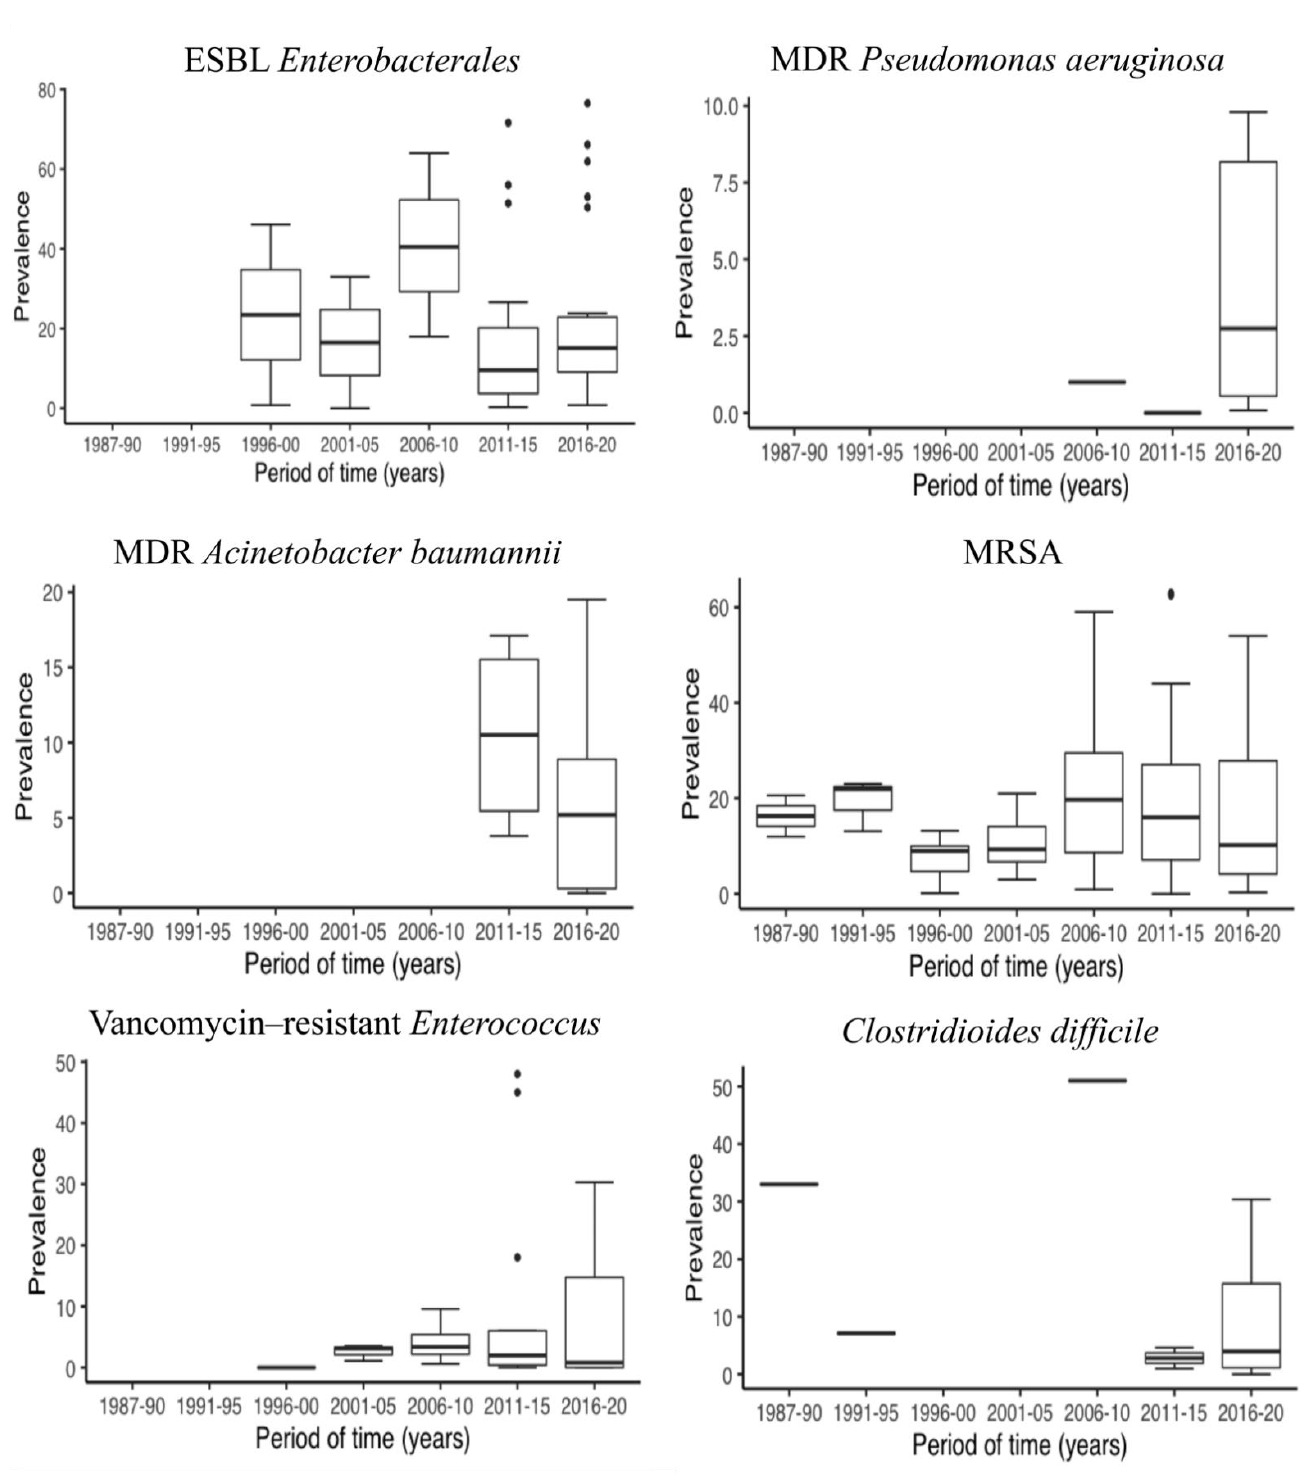
Figure 3. Prevalence of different MDRO in LTCF in 5-year periods. ESBL, extended-spectrum ß-lactamase; MDR, multidrug-resistant; MRSA, methicillin-resistant Staphylococcus aureus.